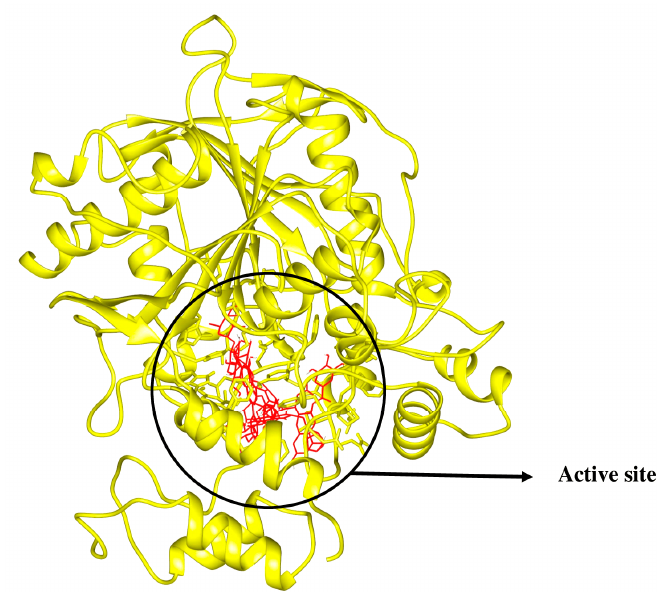
Figure 3. Active compounds were docking in the mentioned active sites colored in red.